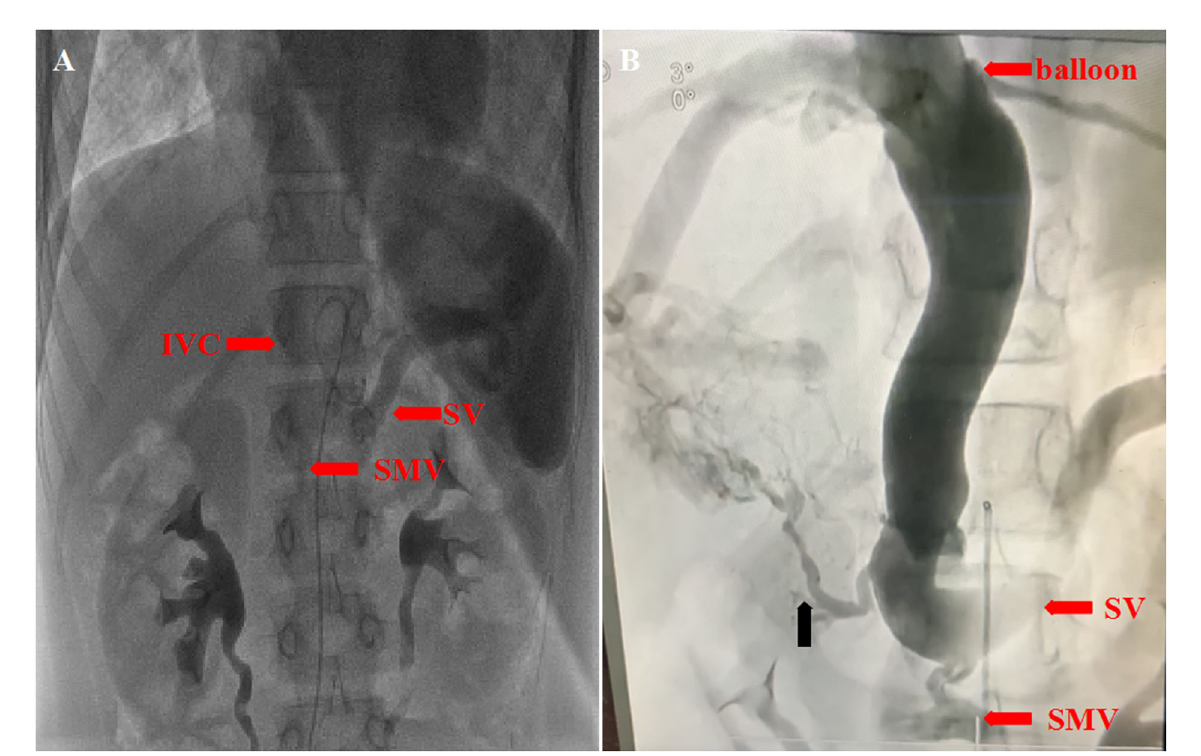
FIGURE3 (A) Delayed splenic arteriography showed that the splenic vein (SV) joined the superior mesenteric vein (SMV), which merged into the inferior vena cava (IVC) directly. (B) The inferior vena cava balloon occlusion test showed a tiny branch of the intrahepatic portal vein (the black